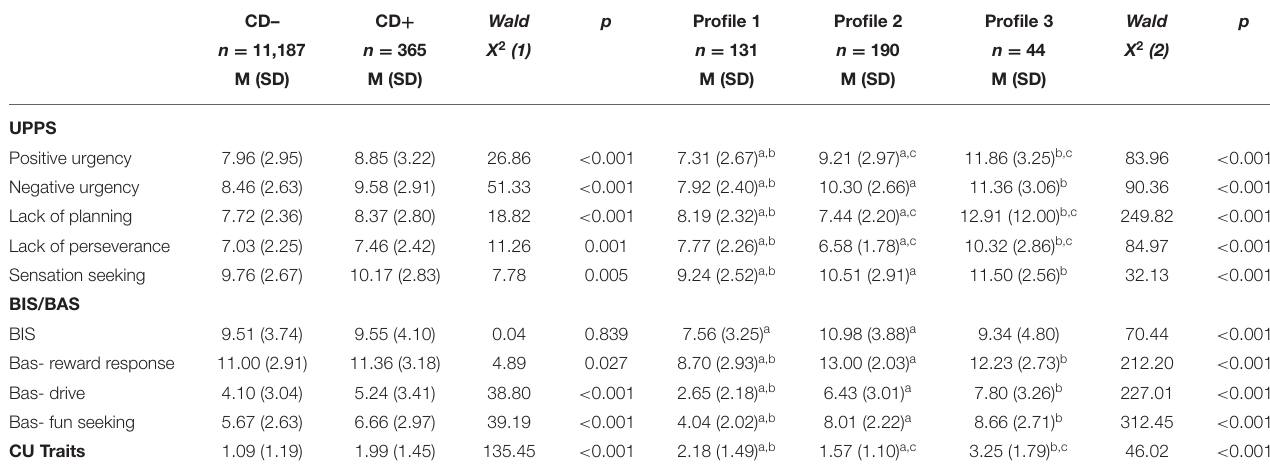
TABLE 2 | Profile indicator variables.